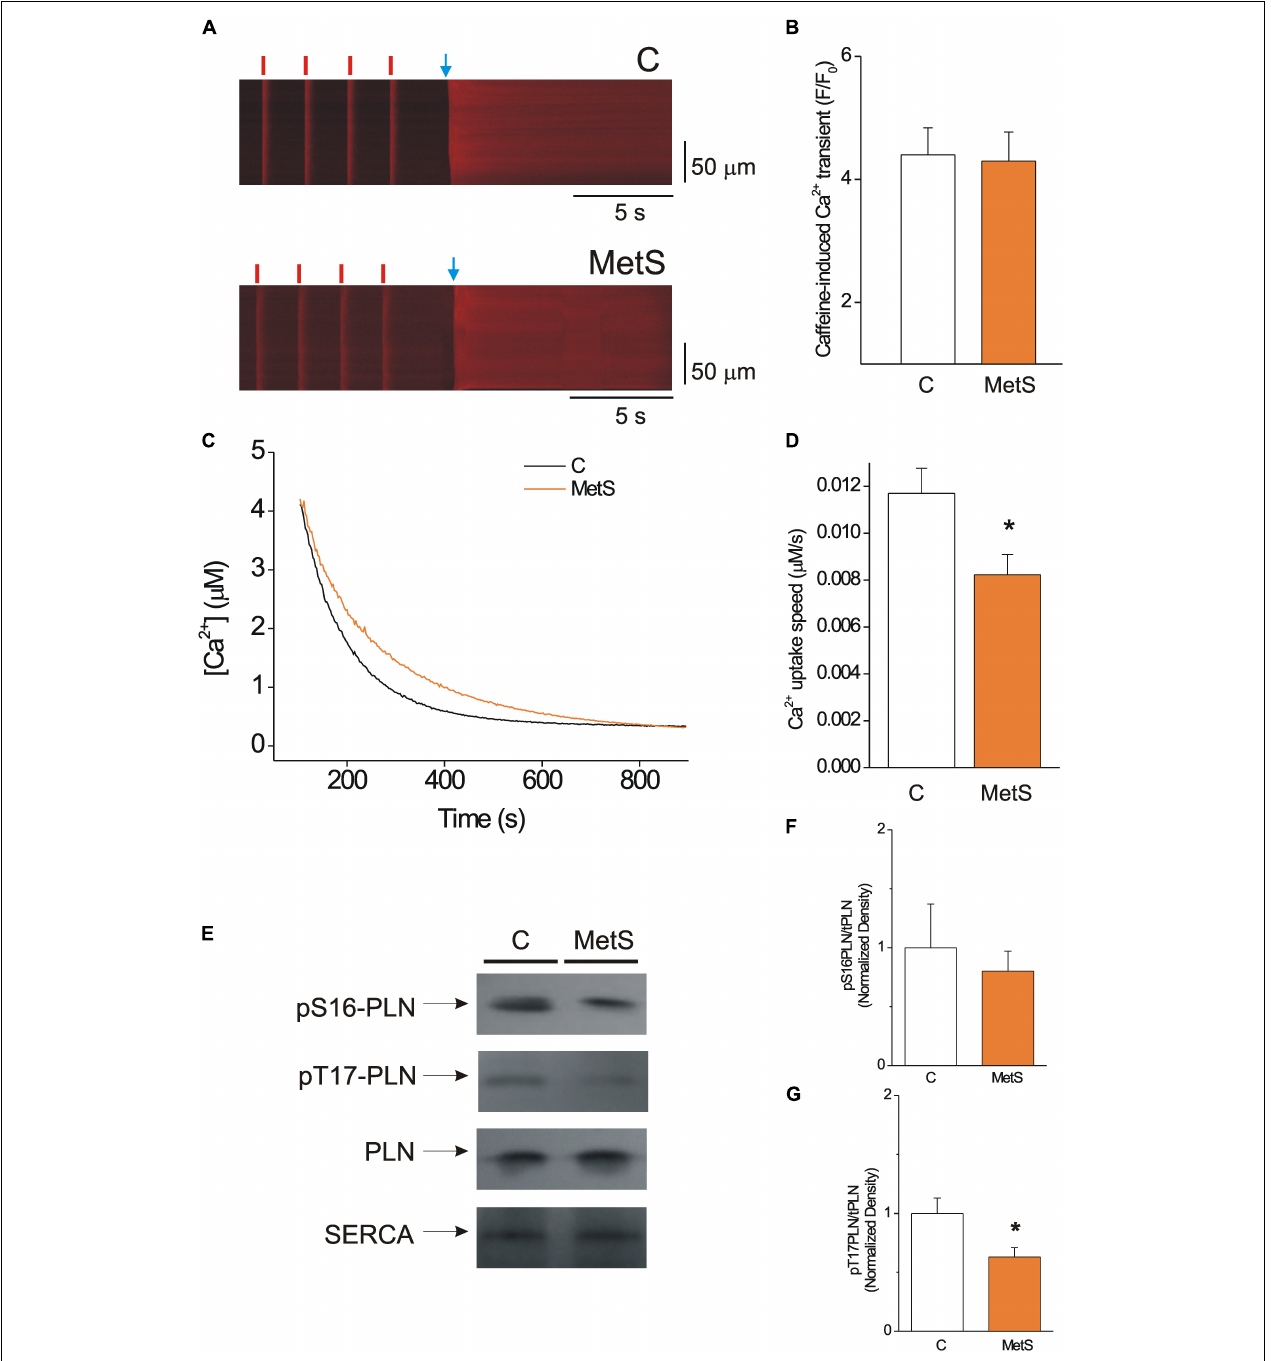
FIGURE 3 | SERCA pump activity is impaired, but this condition does not alter the SR Ca 2 + load in MetS cardiomyocytes. (A) Representative line-scan images of caffeine-induced Ca 2 + transients recorded in isolated Fluo 3-loaded cardiomyocytes from control (C, top ) and MetS ( bottom ) rats to determine SR Ca 2 + loading. Cells were superfused with recording solution and paced at a frequency of 1 Hz ( red lines ) before caffeine challenge (indicated by the blue arrow ). (B) The bar graph represents average values of the caffeine-induced Ca 2 + transient amplitude (F/F 0 ) in control ( white bar , n = 14 cells) and MetS ( orange bar , n = 22 cells) cardiomyocytes. (C) Representative traces of Ca 2 + uptake assays in SR-enriched microsomes obtained from control (C, black trace ) and MetS ( orange trace ) hearts. (D) The bar graph compares the average Ca 2 + uptake speed (in µ M/s) in control ( white bar , n = 10), and MetS ( orange bars, n = 8) microsomal preparations. (E) Representative Western Blot images of phosphorylated PLN at Ser16, Thr17, total PLN, and SERCA pump in whole heart homogenates of control (C) and MetS rats. Bar graphs of normalized phosphorylation levels of pS16 PLN (F) and pT17 PLN (G) in whole heart homogenates of control (C, white bars ) and MetS ( orange bars ) rats. N = 4–7 heart preparations for each experimental group. All values in graphs are presented as Mean ± SEM. ∗ P < 0.05 vs. control values.